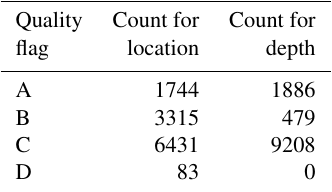
Table 2. Summary of the location and depth quality flags for the extension events between 1920 and